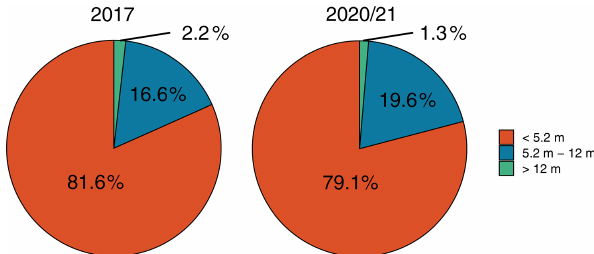
Figure A4. Pie chart for the 2017 and 2020–2021 measurement periods displaying the distribution of vehicle length classes measured by the 24 ATCs surrounding the BT